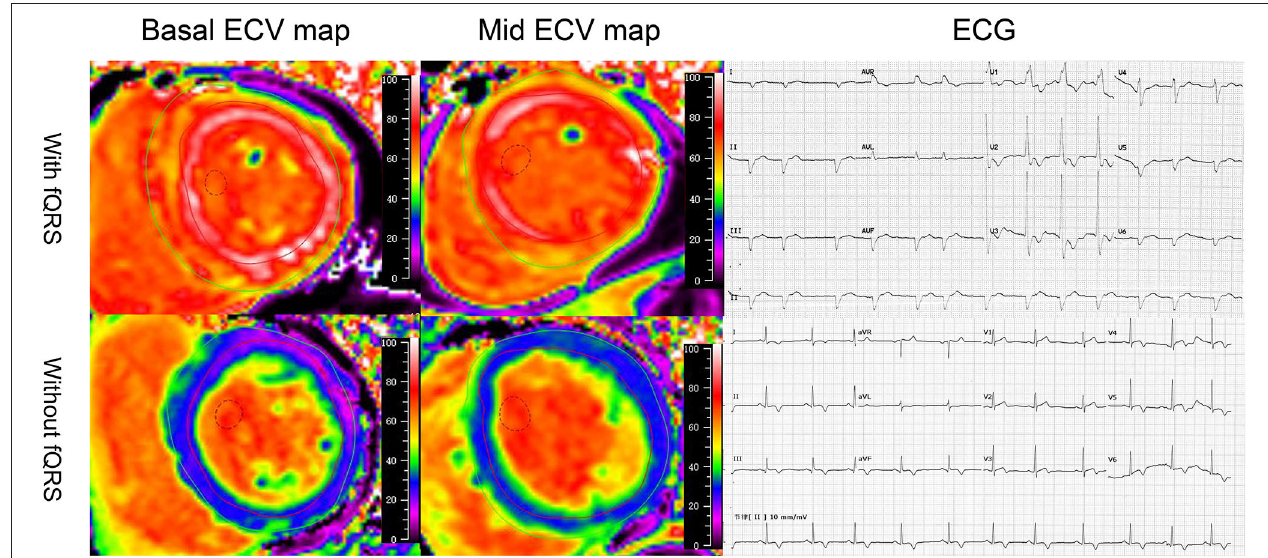
FIGURE 1 | Illustrative case examples of the extracellular volume and electrocardiogram in patients with AL amyloidosis. The patients who presented with fragmented QRS on ECG showed high-basal and mid-ECV value compared with the patients who were absent with fragmented QRS.